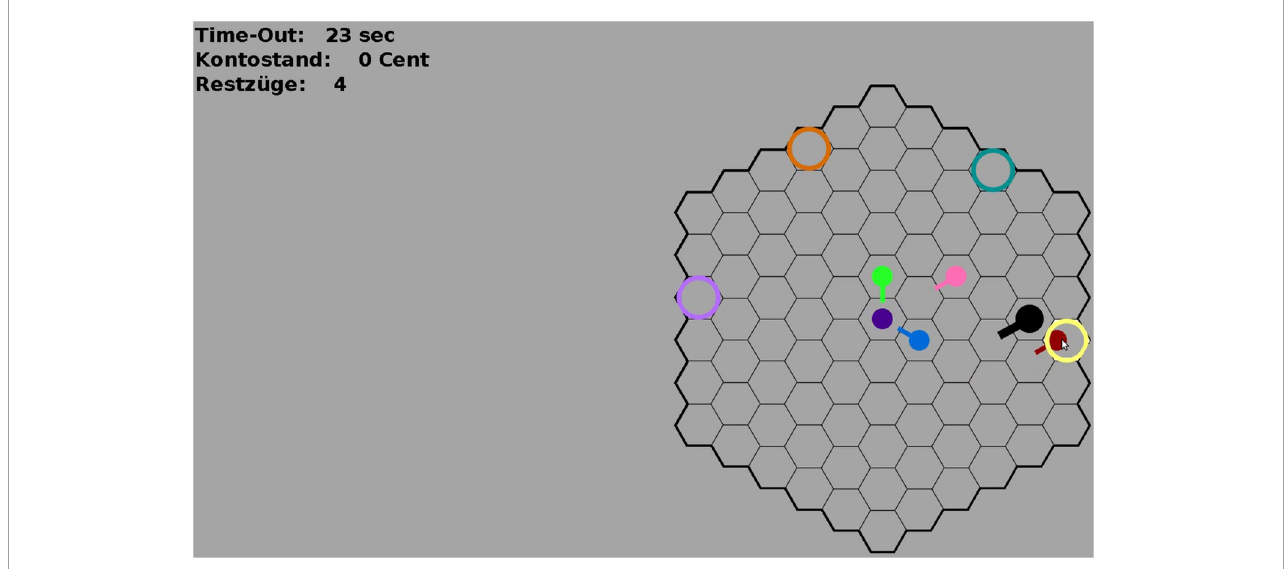
FIGURE4 Screenshot of the HoneyComb game environment. The colored circles are the reward fields. The colored avatars are moving across the field. The avatar of the participant (black) is larger than the avatar of the other participants. Small tails on the avatars are shown for 1000 ms after each move to indicate from where the avatar had moved onto the current field. On the top-left, the remaining time in each round (“Time-Out”), the current account balance of the participant (“Kontostand”), and the remaining moves in the current round (“Restzüge”) are shown. All colors are randomly assigned at the beginning of each game and remain the same during all 30 rounds of the game (1 game = 30 rounds). Colors were chosen to be easily discriminable. Participants were naïve to the exact pay-out probabilities and had to infer the best reward field through